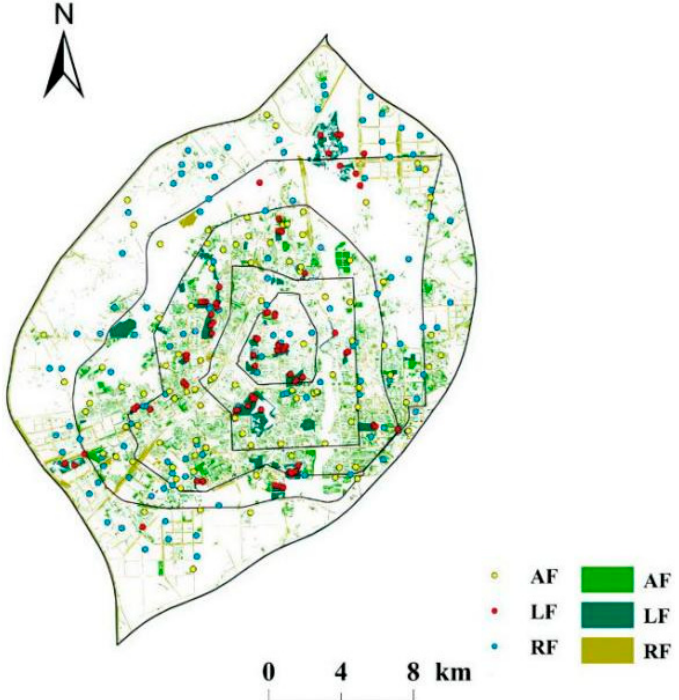
Figure 1. Study area and sample location. The different colored dots in the figure show the distri- bution of the different forest types in the city. The yellow dots represent attached forest (AF), red dots represent landscape and relaxation forest (LF), and blue dots represent road forest (RF). The different colored patches show the specific area sizes of the different forest types. The light green patches represent AF, the dark green patches represent LF, the yellow patches represent RF.